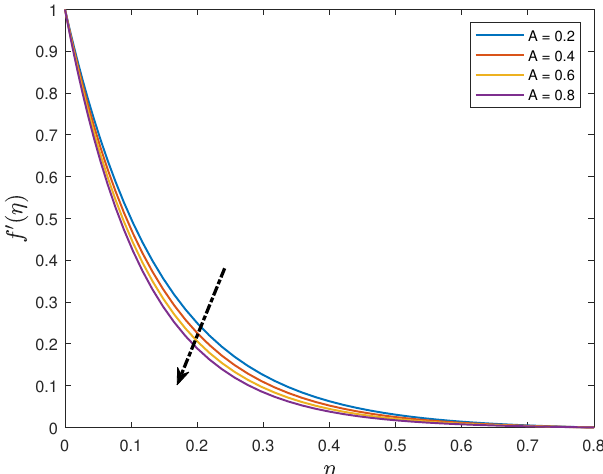
Figure 7. Influence of A on the nanofluid